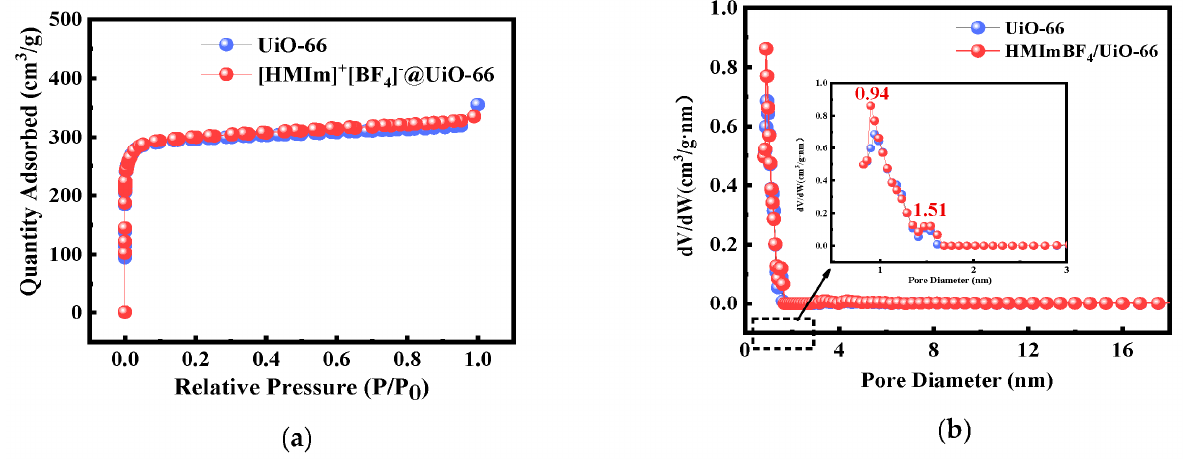
Figure 3. ( a ) Nitrogen adsorption–desorption isotherms of UiO − 66 before and after [HMIm] + [BF 4 ] − modification; ( b ) aperture distribution curve of UiO − 66 before and after [HMIm] + [BF 4 ] − modification.